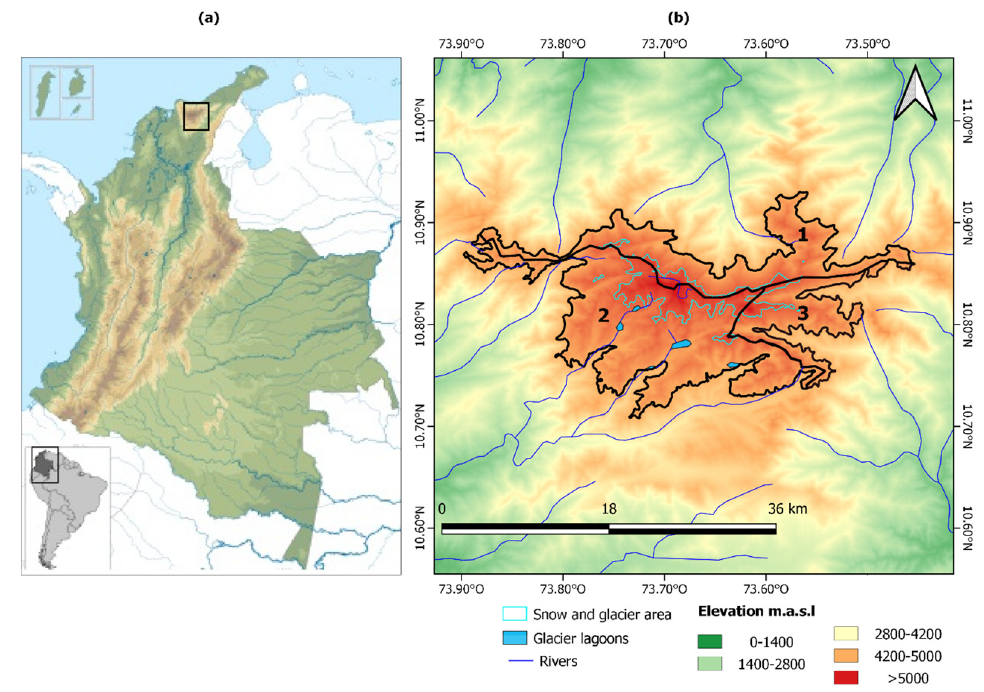
Figure 1. Location of the Sierra Nevada de Santa Marta ( b ) in Colombia and South American continent ( a ). Bounded region encloses the area located above 4000 m.a.s.l. Numbers within the study area represent subdivisions: 1. Northern area, 2. southwest area, and 3. southeast area. (For interpretation of the references to color in this figure legend, the reader is referred to the web version of this article.) .